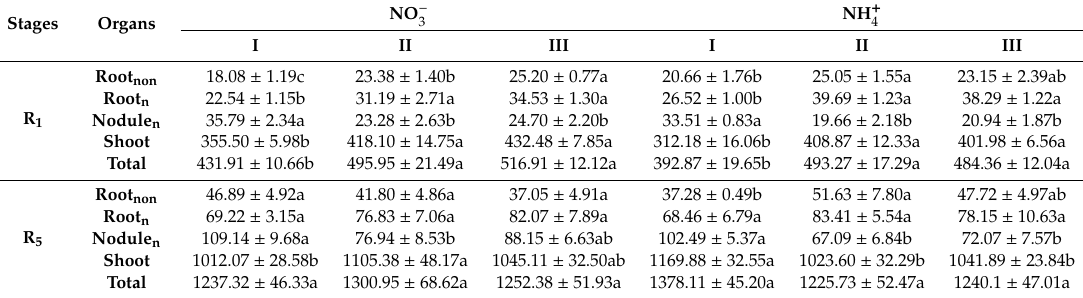
Table 5. N accumulation in each organ of soybean in the dual root system (mg / plant). Stages